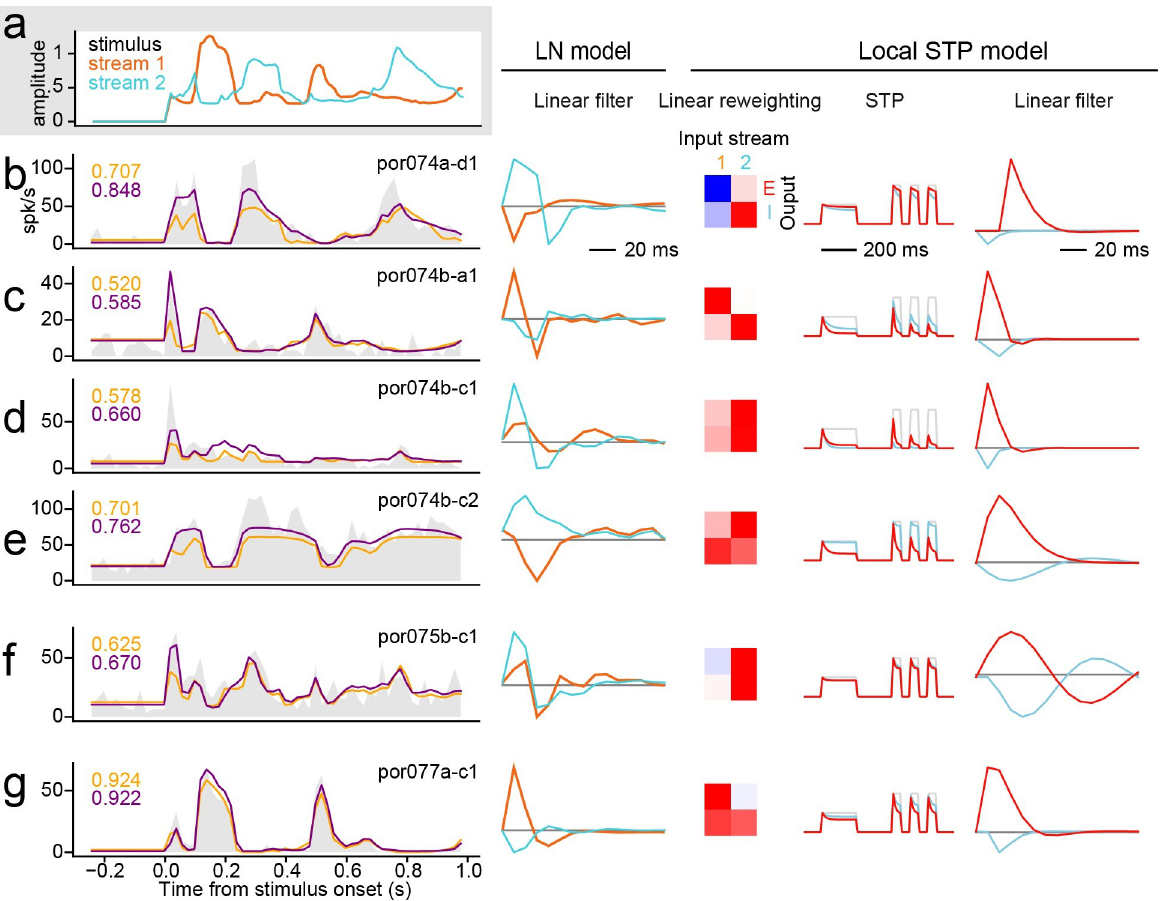
Fig 5. A. Envelope of vocalization-modulated noise streams. B-G. Left column, example PSTH responses of several A1 neurons (gray shading). The spectral position of noise bands was adjusted to fall within the receptive field of each neuron, but the envelopes were the same for each recording. Responses were sometimes dominated by one stream (e.g., unit B tracks stream 2 and G tracks stream 1), but could also track both (e.g., unit F). Response dynamics also vary substantially, from sustained, following the stimulus envelope (G), to highly transient responses that attenuate after sound onset (D). Numbers at upper left of PSTH plots indicate prediction correlation for the linear-nonlinear (LN) model (orange) and local short-term plasticity (STP) model (blue). Predicted PSTHs are overlaid on the actual PSTH. Second column shows linear filters from the LN model for each neuron, whose gain reciprocates the PSTH responses. Columns at right show spectral weights, STP properties and linear filters for the largest (positive gain, red) and smallest (negative gain, blue) temporal filter in local STP models for the same neurons.